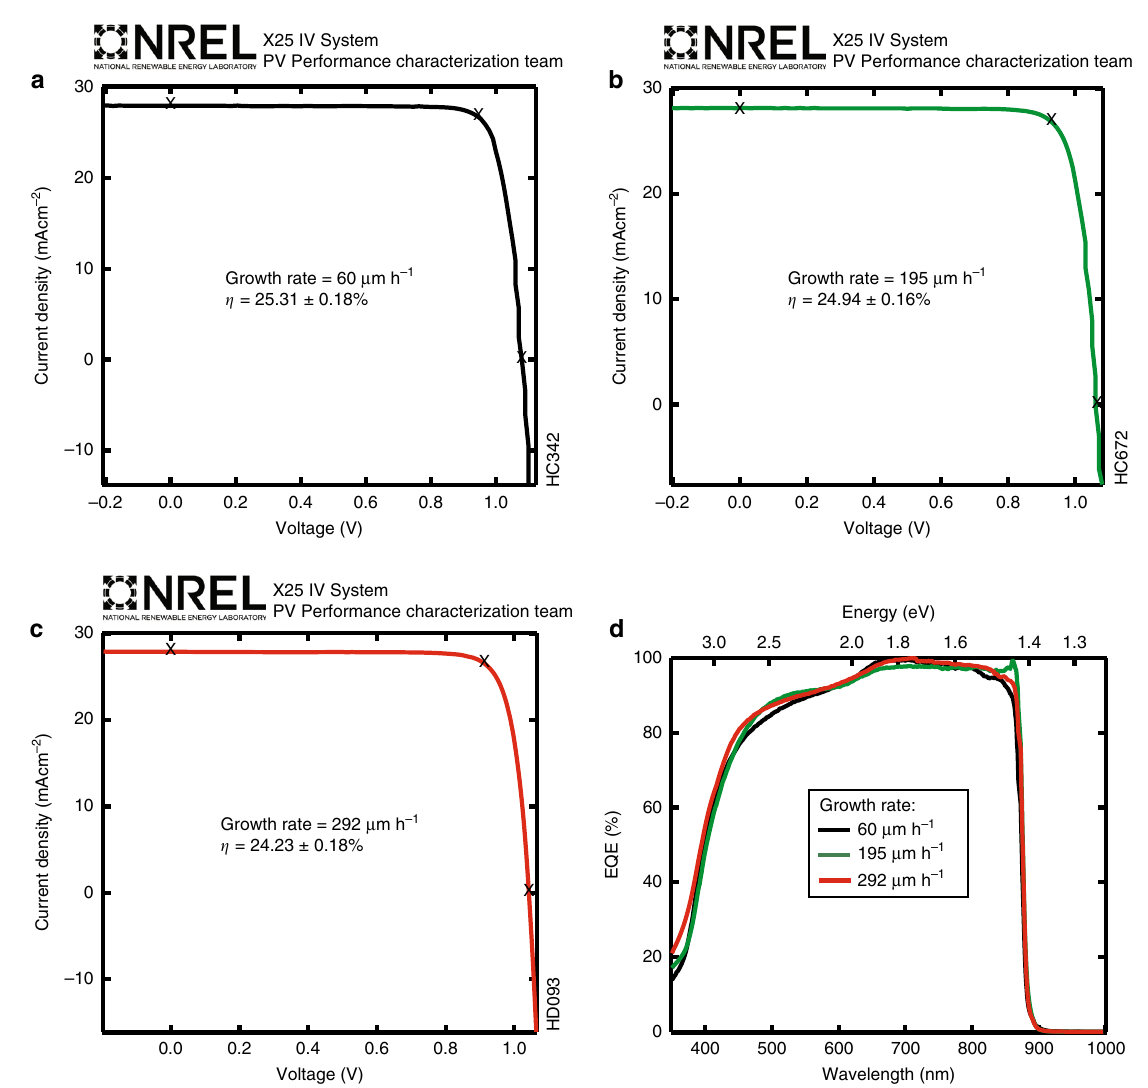
Fig. 4 Certi fi ed device performance of GaAs solar cells grown at high GaAs growth rates. J – V characteristics of 0.25 cm 2 single-junction GaAs cells with a MgF2/ZnS antire fl ection coating measured under the AM1.5G spectrum grown at growth rates of 60 µ m h − 1 on 4°B miscut substrate ( a ), 195 µ m h − 1 on